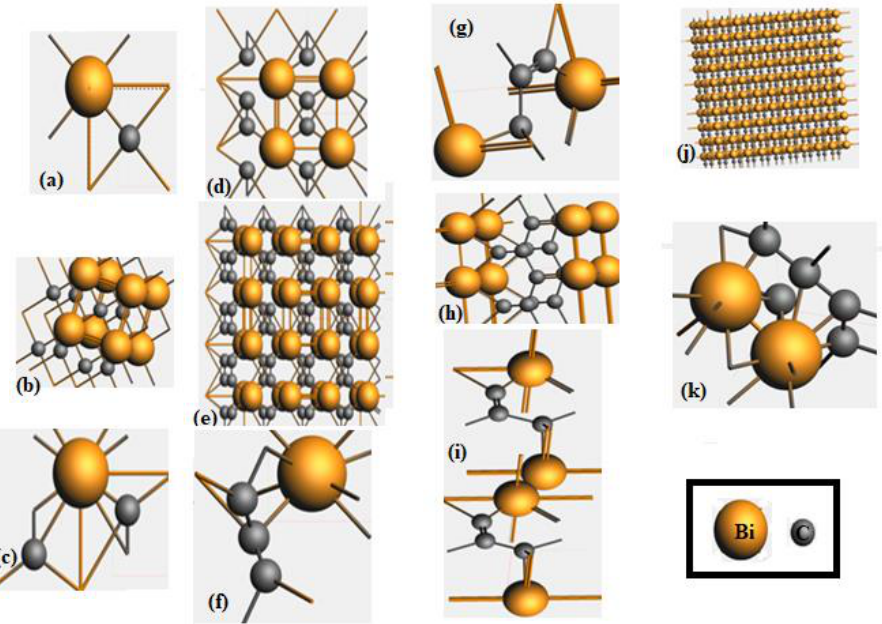
Figure 1. The optimized structure viewed along z-axis for ( a ) BiC unit cell ( b ) BiC supercell ( c ) BiC 2 unit cell ( d ) BiC 2 slab ( e ) BiC 2 supercell ( f ) BiC 3 unit cell ( g ) Bi 2 C 3 unit cell ( h ) Bi 2 C 3 supercell ( i ) Bi 2 C 3 bilayer ( j ) Bi 2 C 3 monolayer ( k ) Bi 2 C 5 unit cell. The orange spheres represent Bi, whereas gray spheres indicate C atoms. The single, double, and aromatic bonds (with dotted lines) between Bi and C atoms are shown.